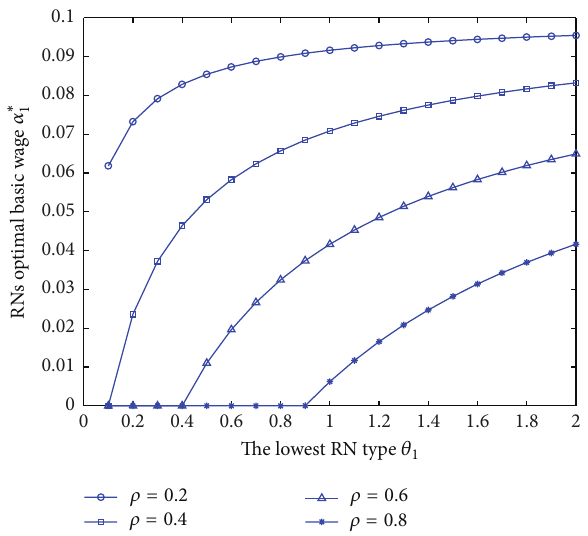
Figure 5: RNs’ bonus coefficient 𝛼 ∗ 1 versus the lowest RN type 𝜃 1 for fixed 𝑁 1 = 2 and 𝑈 = 0.1 .